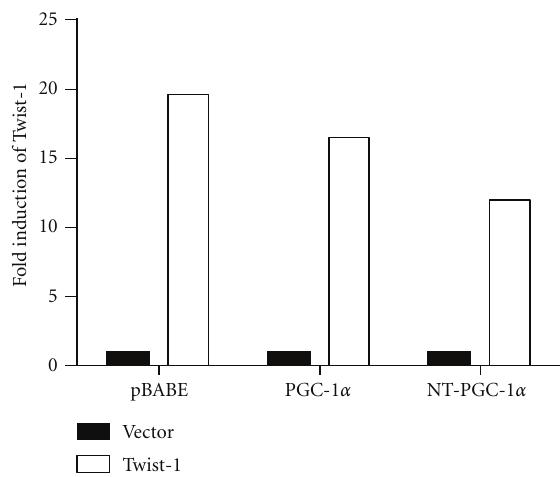
Figure 3: The elevated Twist-1 levels in brown preadipocytes by retroviral infection. Immortalized PGC-1 α - deficient brown preadipocyte cells that express pBABE-neo vector, PGC-1 α , or NT- PGC-1 α were transduced with pBABE-zeo or Twist-1 retrovirus. Zeocine-resistant cells were pooled and Twist-1 expression was assessed by real time-PCR analysis. Relative abundance of Twist-1 mRNA was normalized to that of cyclophilin